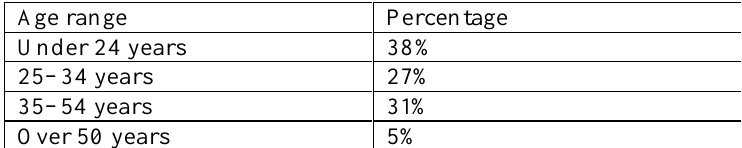
Range of Age of Survey